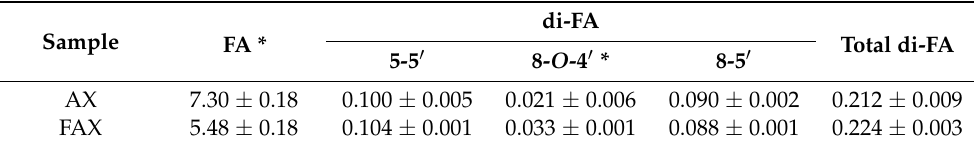
Table 1. Composition of AX and FAX phenolic